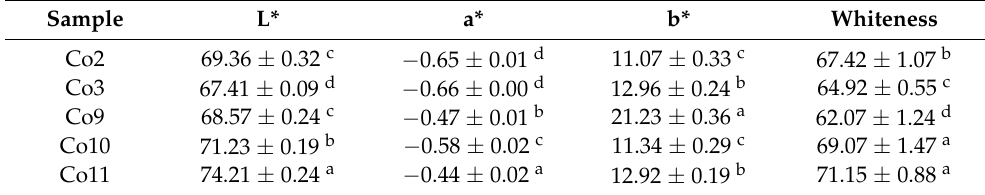
Table 2. Chroma analysis of Co prepared under different extraction pH